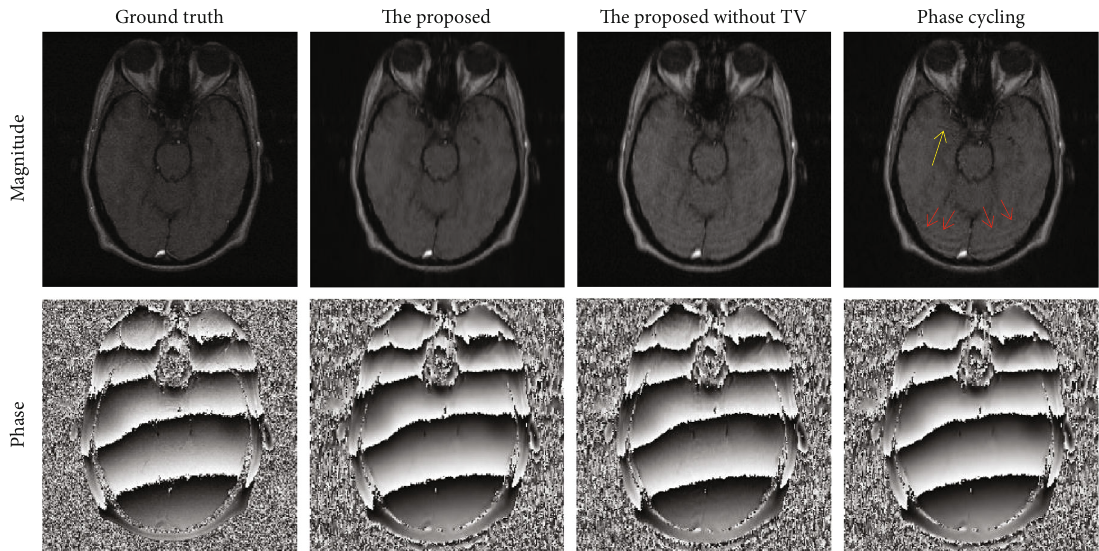
Figure 6: The results on another brain dataset for the proposed algorithm with and without TV regularization and the phase cycling